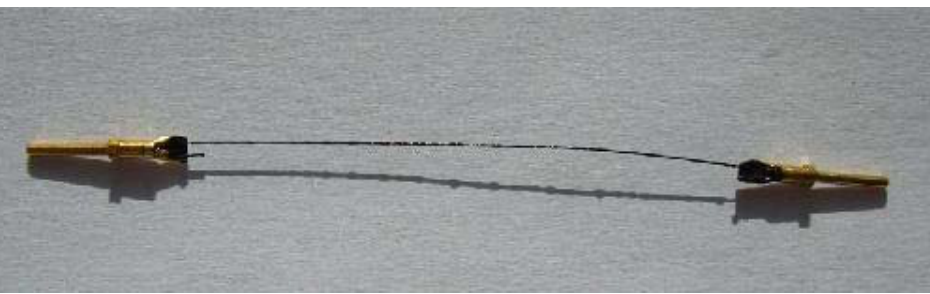
Figure 8. Flexible temperature sensor on yarn with contact